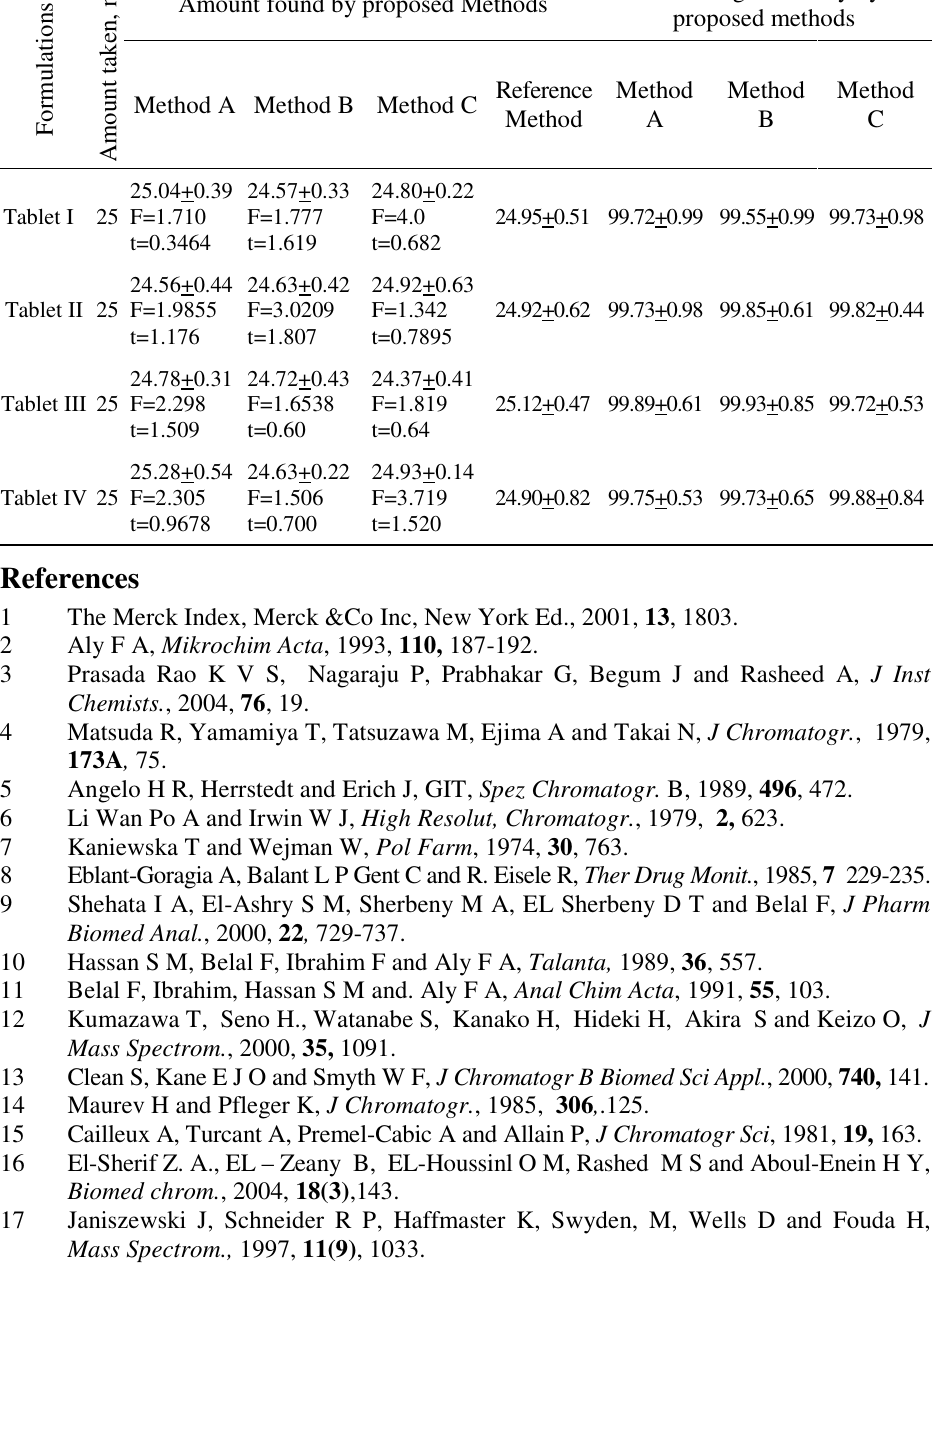
Percentage recovery by proposed